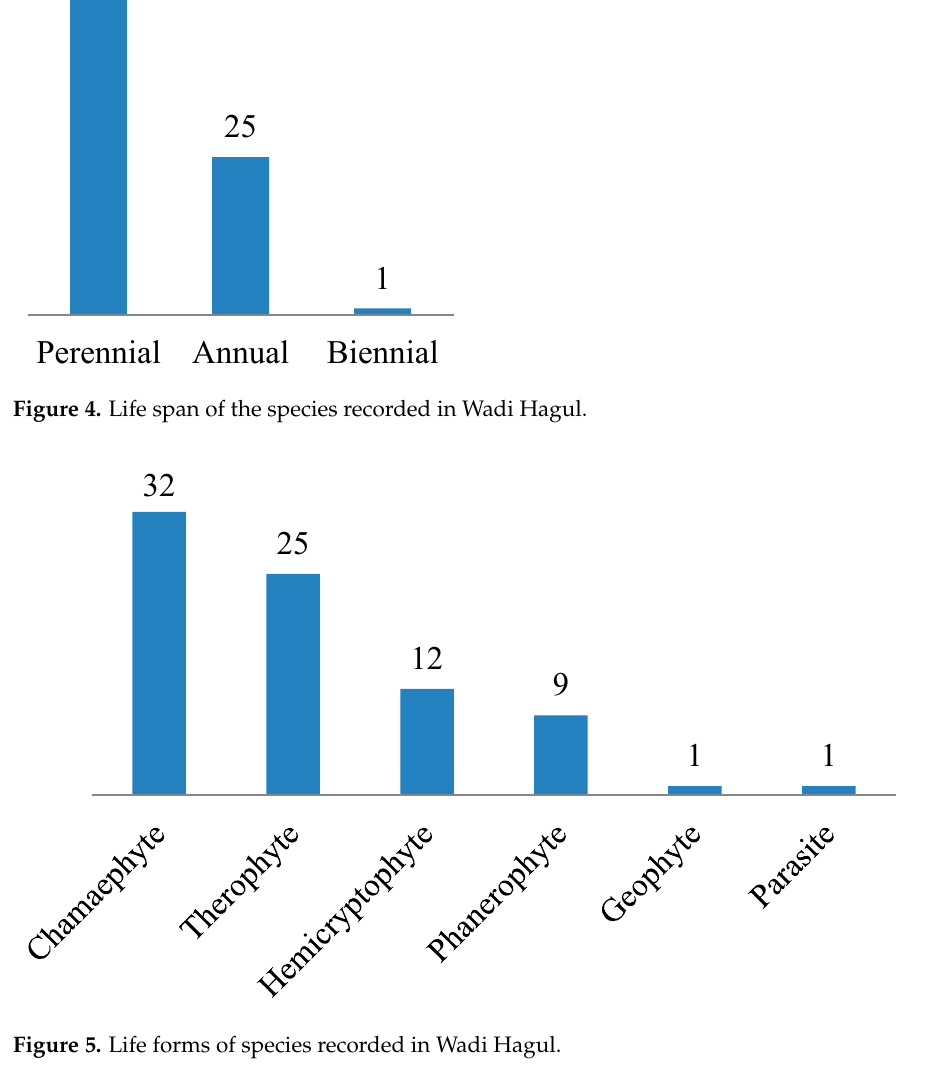
Figure 5. Life forms of species recorded in Wadi Hagul. With respect to a phytogeographical region, monoregional geoelements were the most common floristic category (40 species, 50%), followed by biregionals (27 species, 33.8%), and pleuriregionals (8 species, 10%). Cosmopolitan and palaeotropical species were represented by one and one species, respectively (Table 2 and Figure